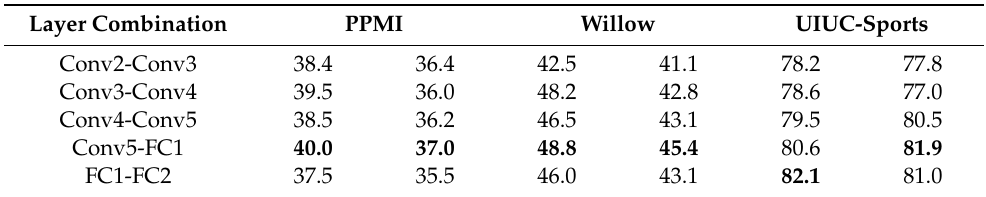
Table 5. Classification accuracy (%) of the ASL network. For each dataset, the first column is for the teacher network and the second column is for the student network. Two layers of the teacher network are bound to Conv3 and FC1 layers in the student network.